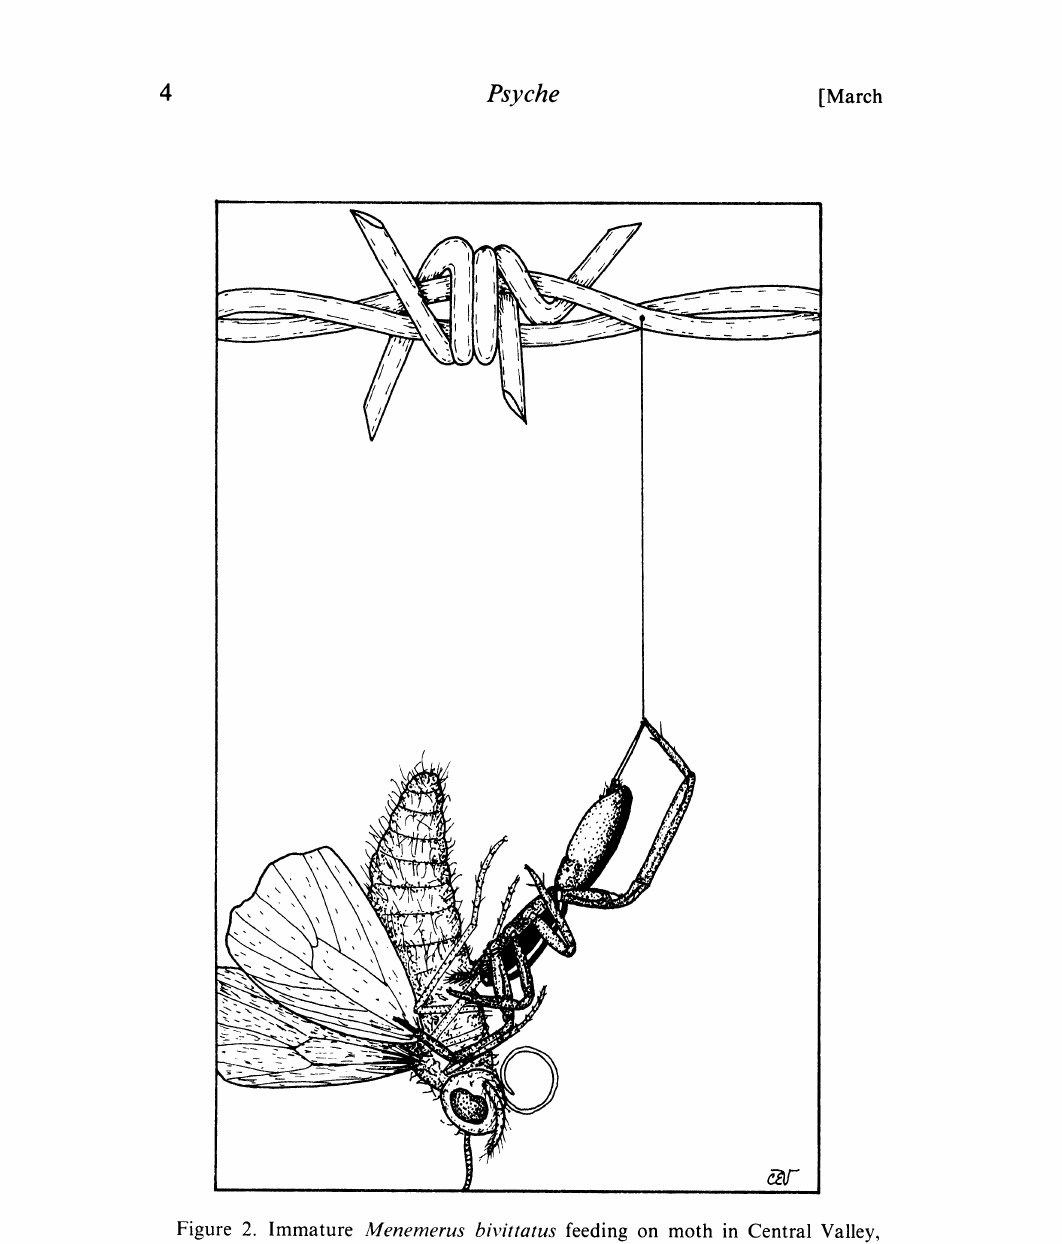
Figure 2. Immature Menemerus bivittatus feeding on moth in Central Valley, Costa Rica. The spider has dropped on its dragline beneath the fencing